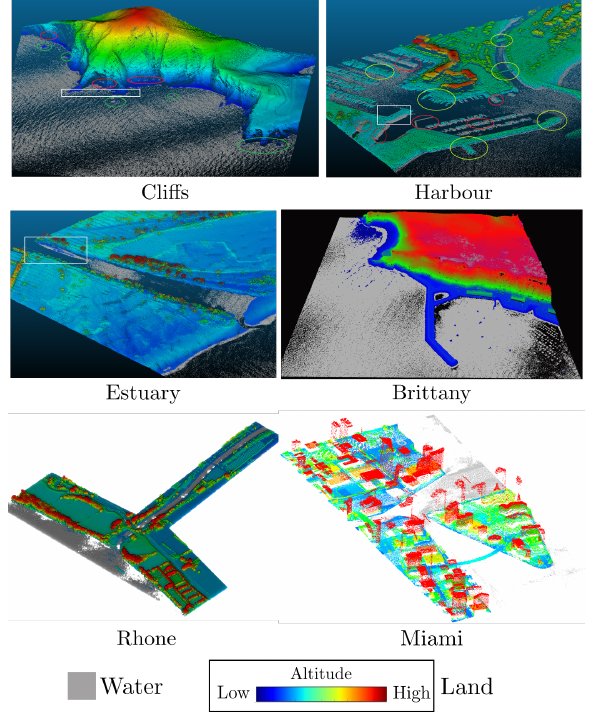
Figure 2: Classification results displayed in 3D for various areas of interest (see text for more